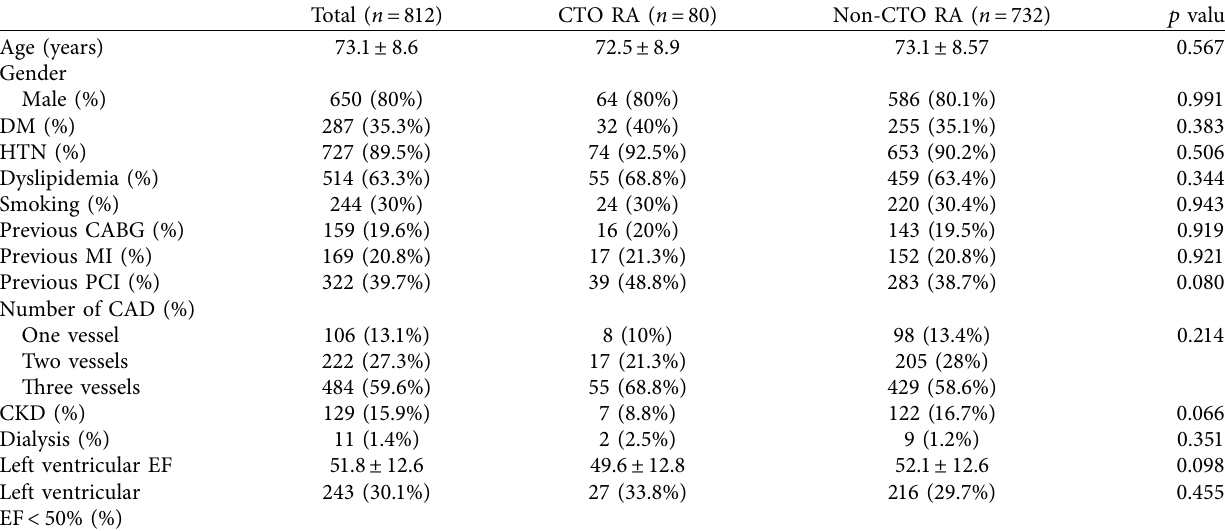
Table 1: Baseline clinical characteristics of the study